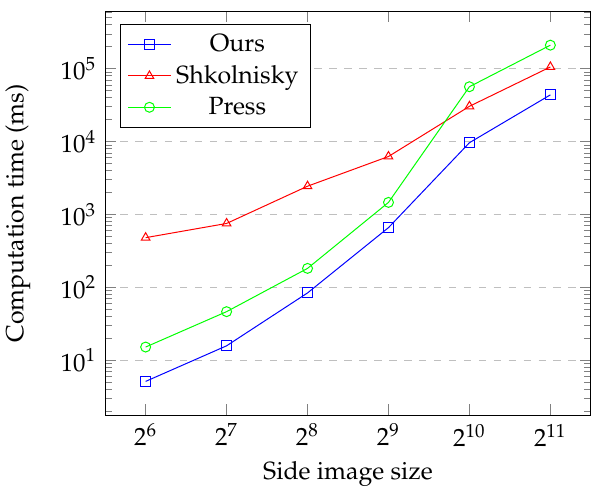
Figure 14. Execution times of the proposed method compared with the best multiscale DRT and Fourier-slice inversion alternatives.